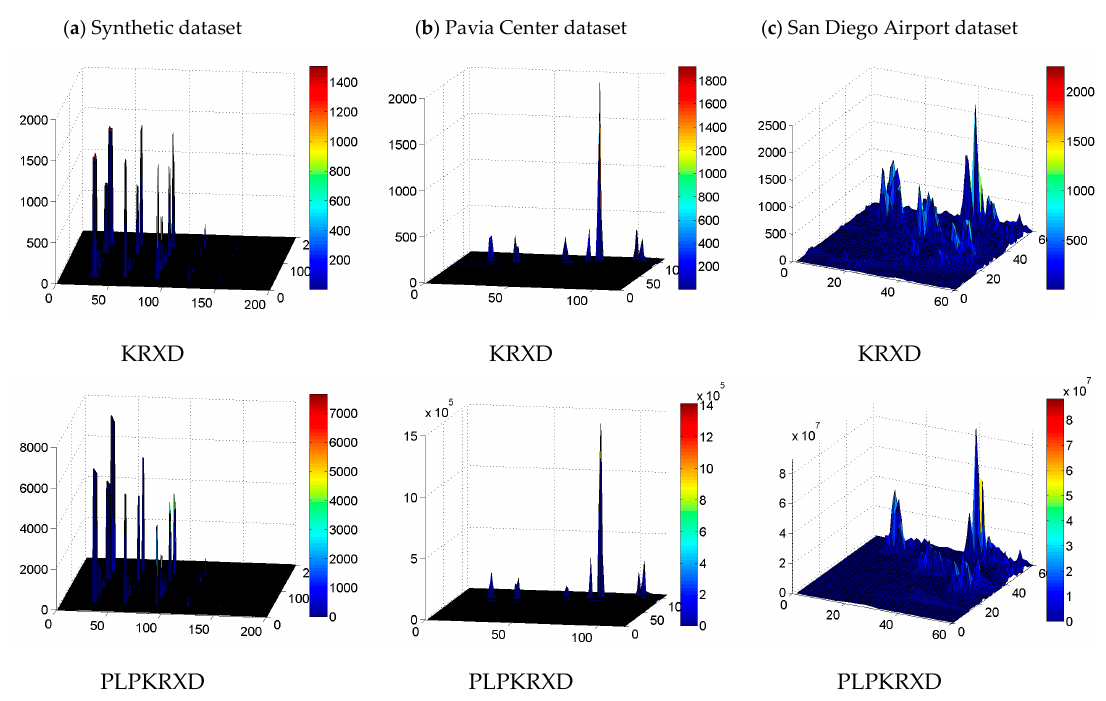
Figure 13. The three-dimensional (3D) plots of the detection results obtained by the KRXD and the PLP-KRXD on three HSI datasets. ( a ) Synthetic dataset; ( b ) Pavia Center dataset; ( c ) San Diego Airport dataset.